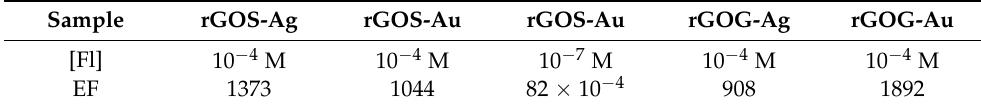
Table 2. EF values of the hybrid films made of rGOS combination with AgNPs and AuNPs.